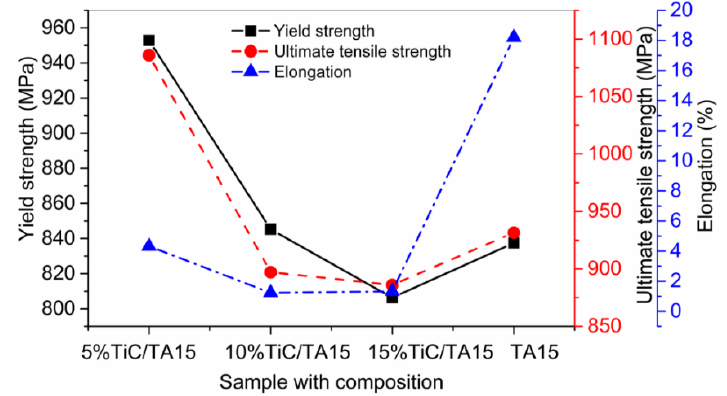
Figure 6. TiC + TA15 composites mechanical characteristics, including yield strength, ultimate tensile strength, and elongation; based on the data provided in Ref. [48].